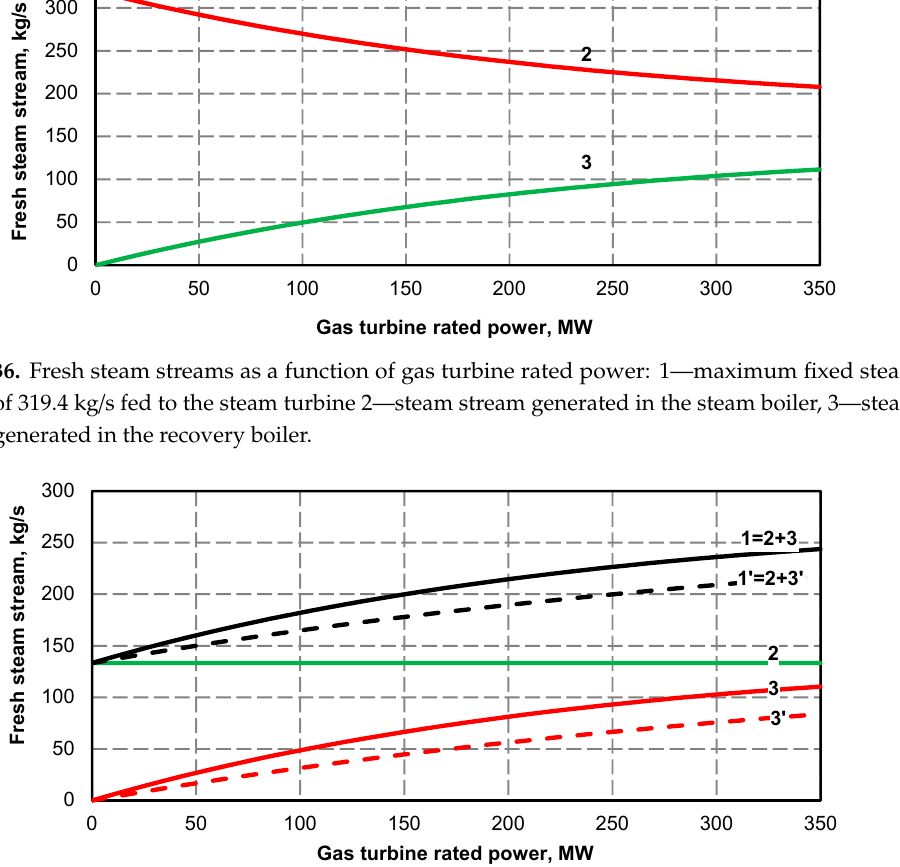
outlays on a new condenser is about 50 MW.